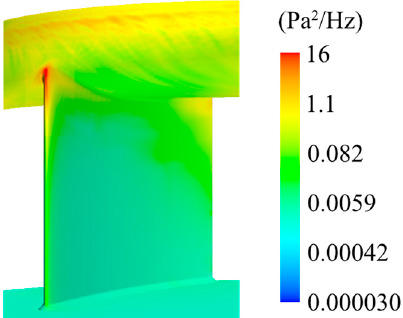
Figure 5. PSD of the wall the wall pressure fluctuations at BPF (326.7 Hz).